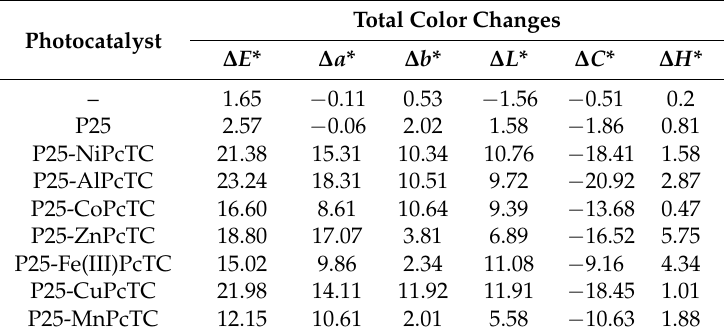
Table 5. Color changes of the photocatalytic coatings after 72 h of exposure to Xenon light. Total Color Photocatalyst